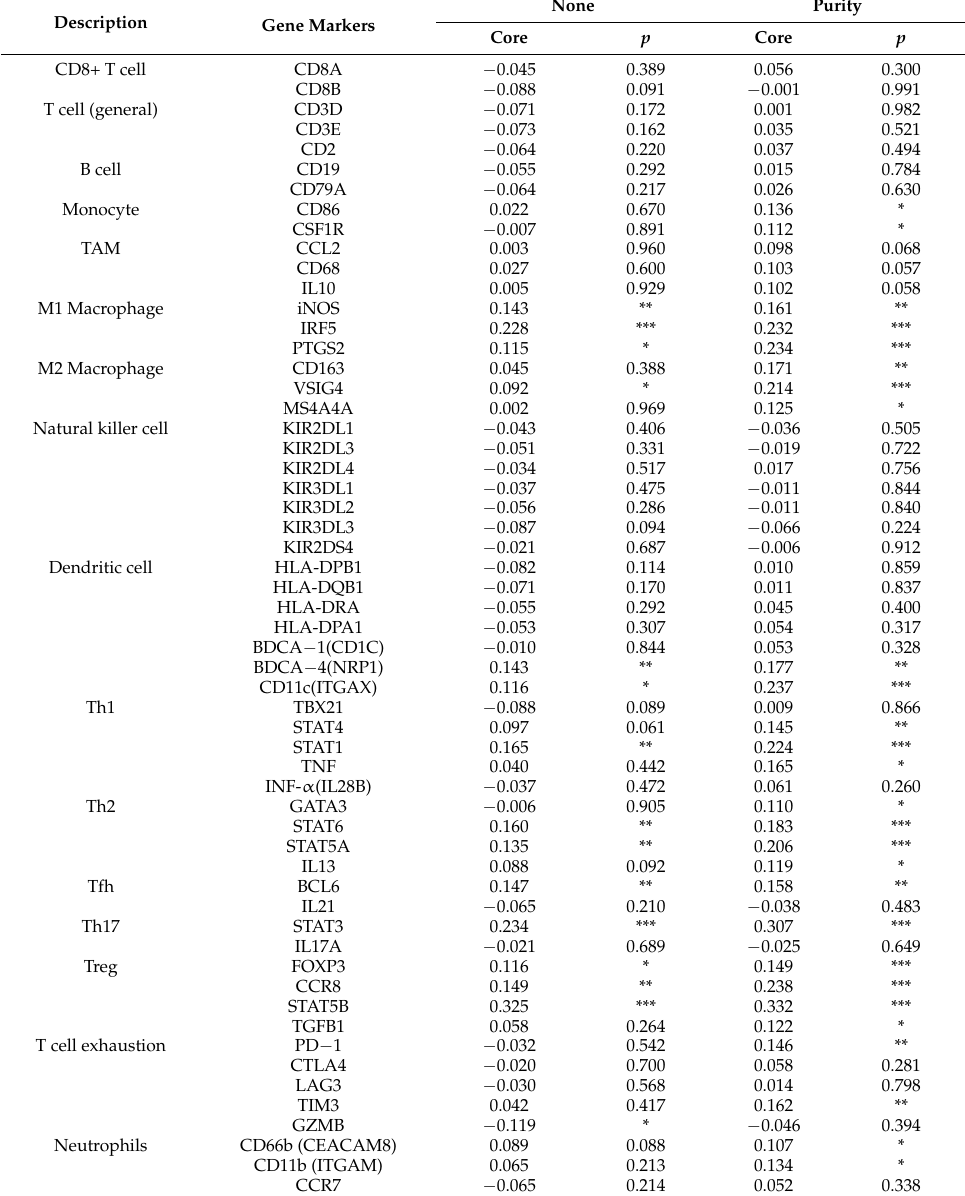
Table 2. Correlation analysis between PVR and related markers of immune cells in